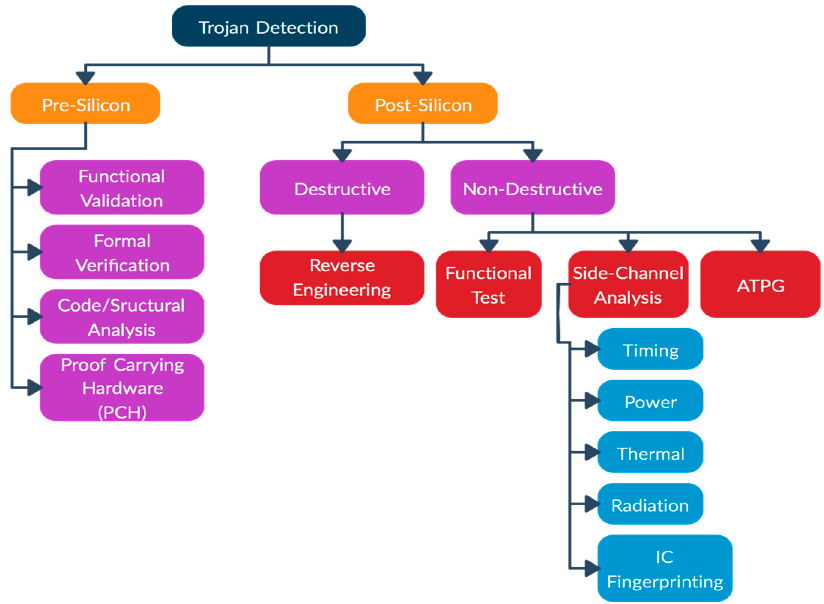
Figure 6. Hardware Trojan Detection Techniques. ATPG: automatic test-pattern